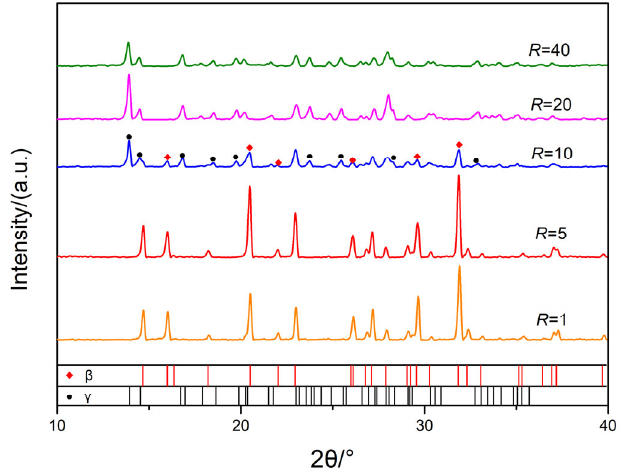
Figure 6. XRD patterns of ultrafine HMX prepared with different R.